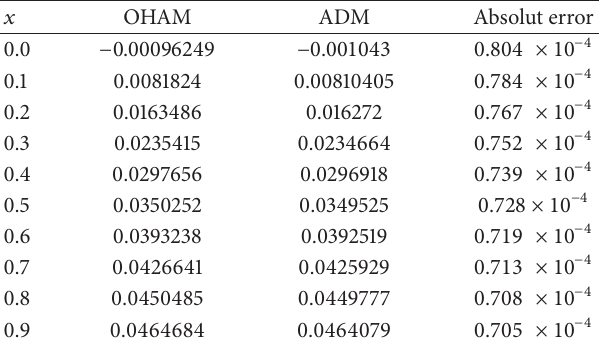
Table 2: Comparison of (OHAM) and (ADM) for drainage velocity